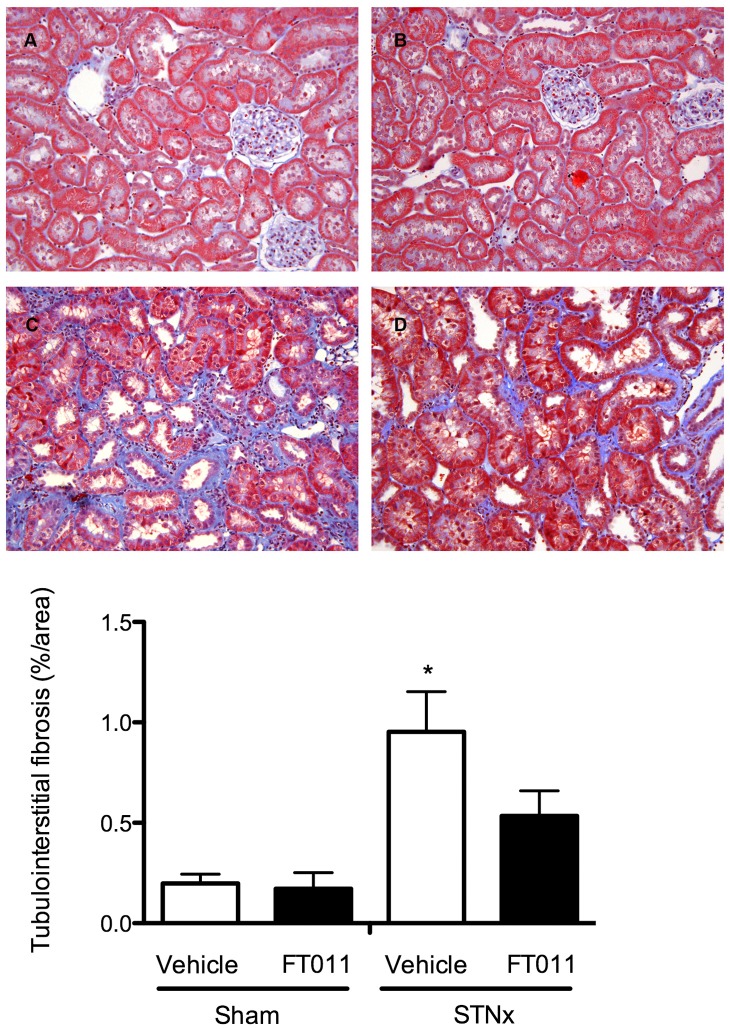
Representative photomicrograph of Masson’s stained sections from STNx rats.Representative photomicrograph of modified Masson’s trichrome-stained sections showing tubulointerstitial fibrosis in sham and STNx rats treated with and without FT011. In sham (A) and sham treated with FT011 (B) there were minimal cortical interstitial fibrosis, while STNx (C) was associated with an increase in interstitial fibrosis (blue). Treatment of STNx rats with FT011 (D) was associated with a trend towards a reduction in tubulointerstitial fibrosis. Magnification x400. Quantitative data are expressed as mean ± SEM. *P<0.05 compared with shams.